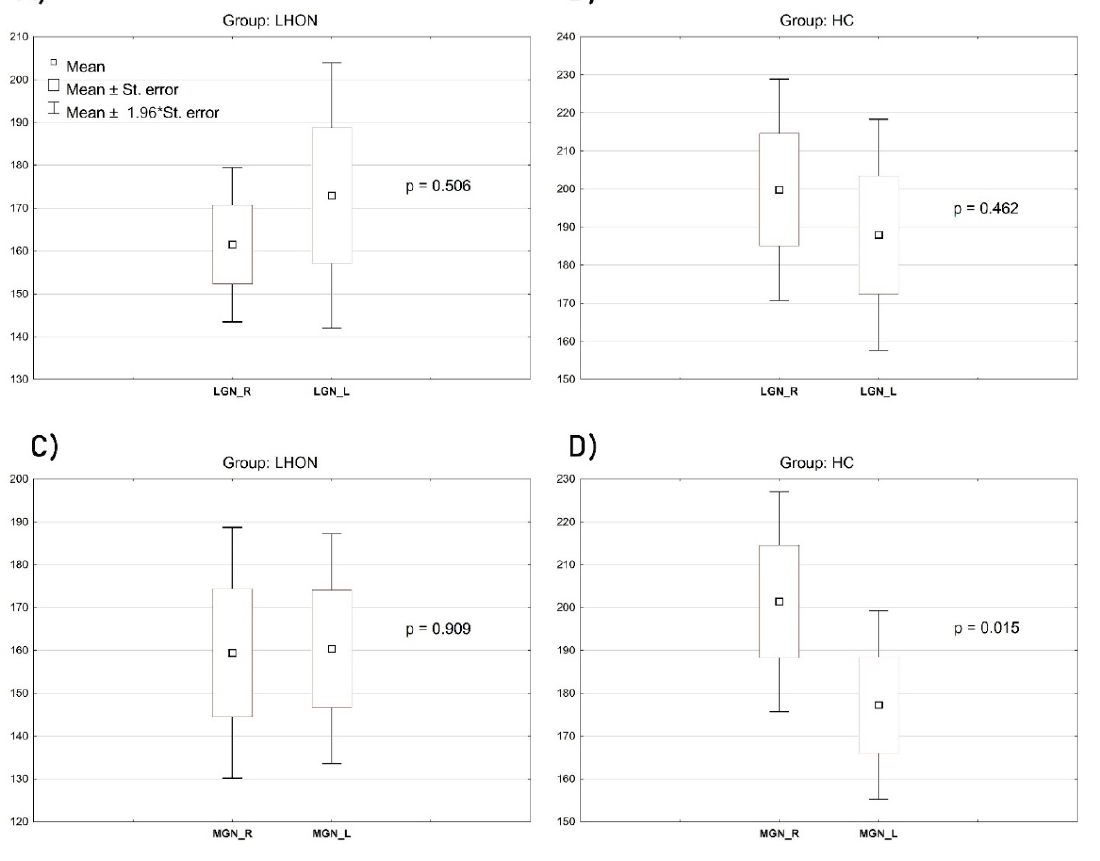
Figure 5. Within-group effects of the right and left LGN ( A , B ) and the right and left MGN ( C , D ) (mm 3 ). The figures show mean, standard error, the range of 1.96 standard error and the level of statistical significance of the within-subjects effect .